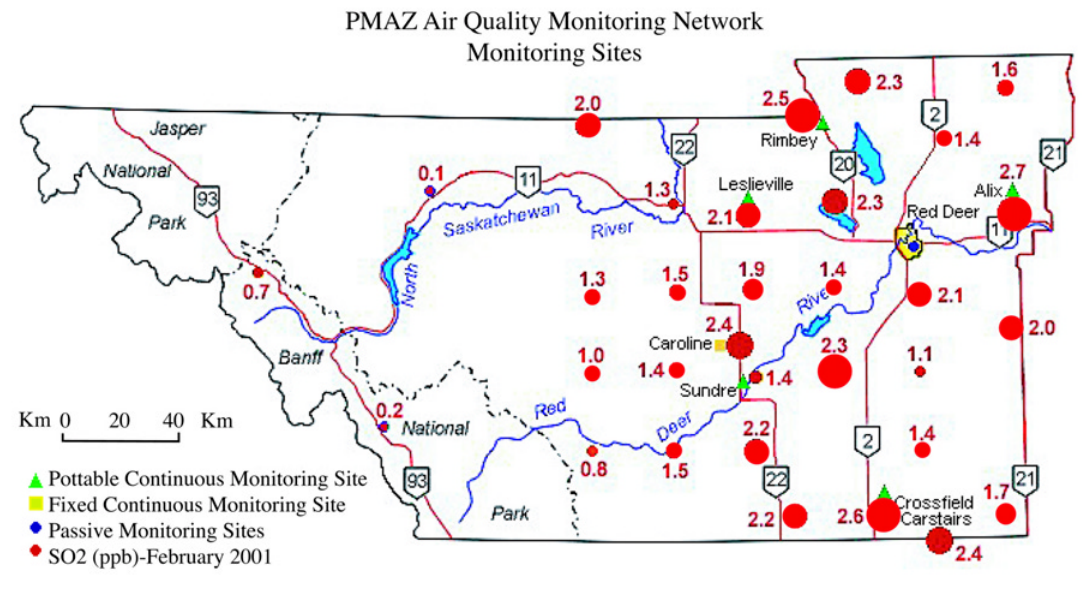
FIGURE 7. February 2000 SO 2 distribution in Parkland Air Monitoring Zone Canada (courtesy from